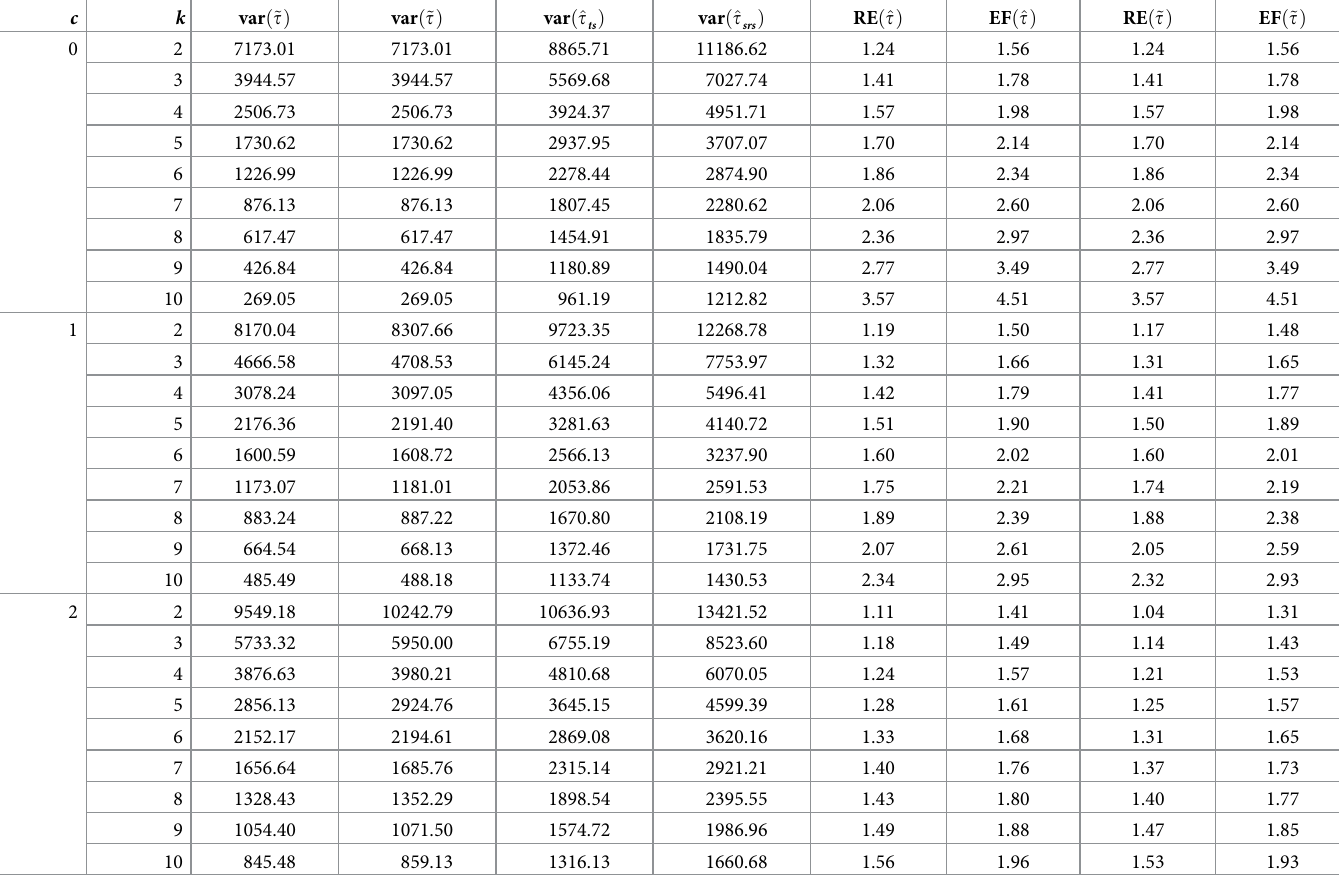
Table 2. The variances of ^ t , ~ t , ^ t and ^ t are computed with the same effective sample sizes for the buttercups population when the population was partitioned ts SRS into 12 PSUs. The relative efficiencies and the efficiencies of both estimators of ATIS are computed where m =